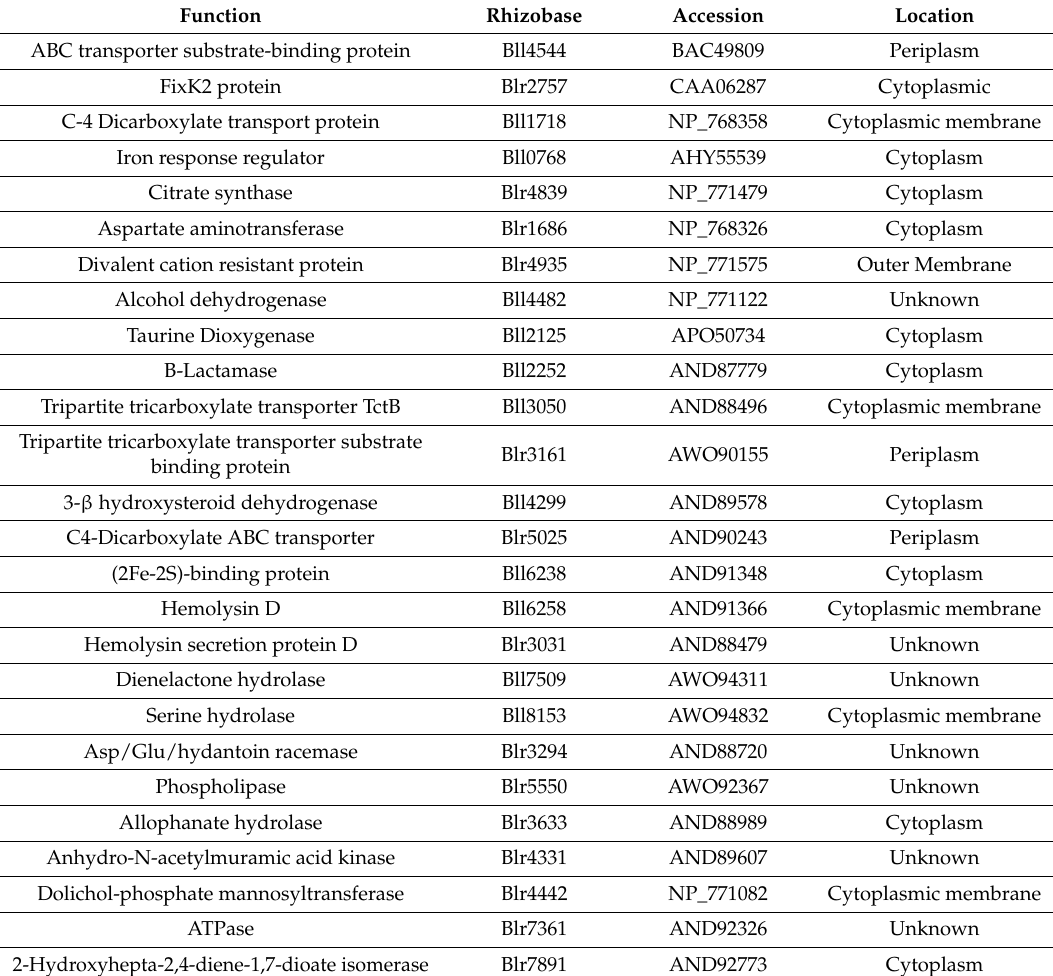
Table 2. Examples of B. diazoefficiens genes expressed during the symbiosis of soybean root nodules following the pattern displayed in Figure 1B.